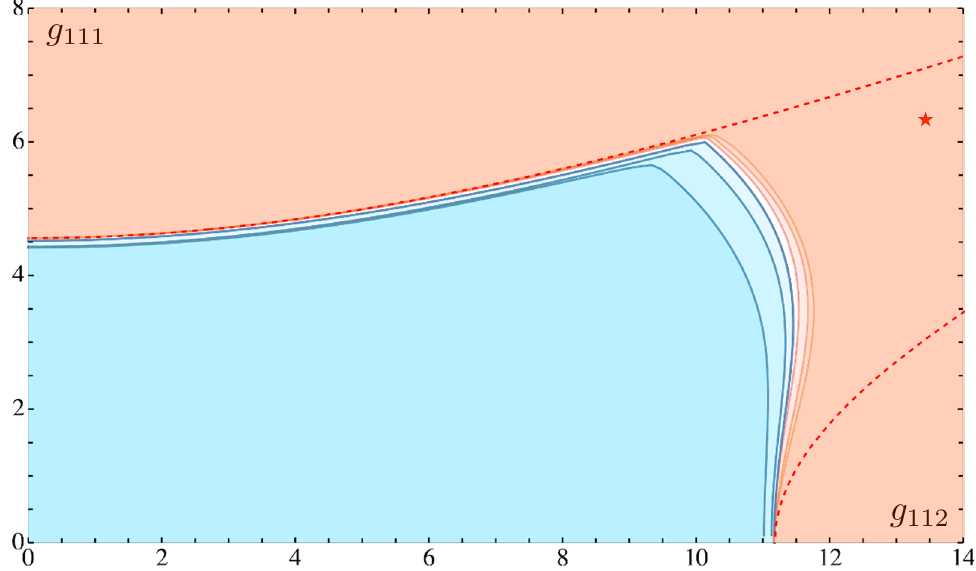
Figure 6 . Dual (red) and Primal (blue) excluded/allowed regions once the full system of amplitudes is included. 22 The multi-component improved boundary is now rigorously trapped between the primal and dual bounds. The red dashed line is the previous single component boundary. As we now impose the full system constraints the bound improves dramatically excluding most of the horn like figure. The red star point, for instance, was allowed (feasible) before from the primal problem perspective (it was blue in figure 2) and is now excluded. Once again, we restrict the plot to the first quadrant due to g ↔ − g